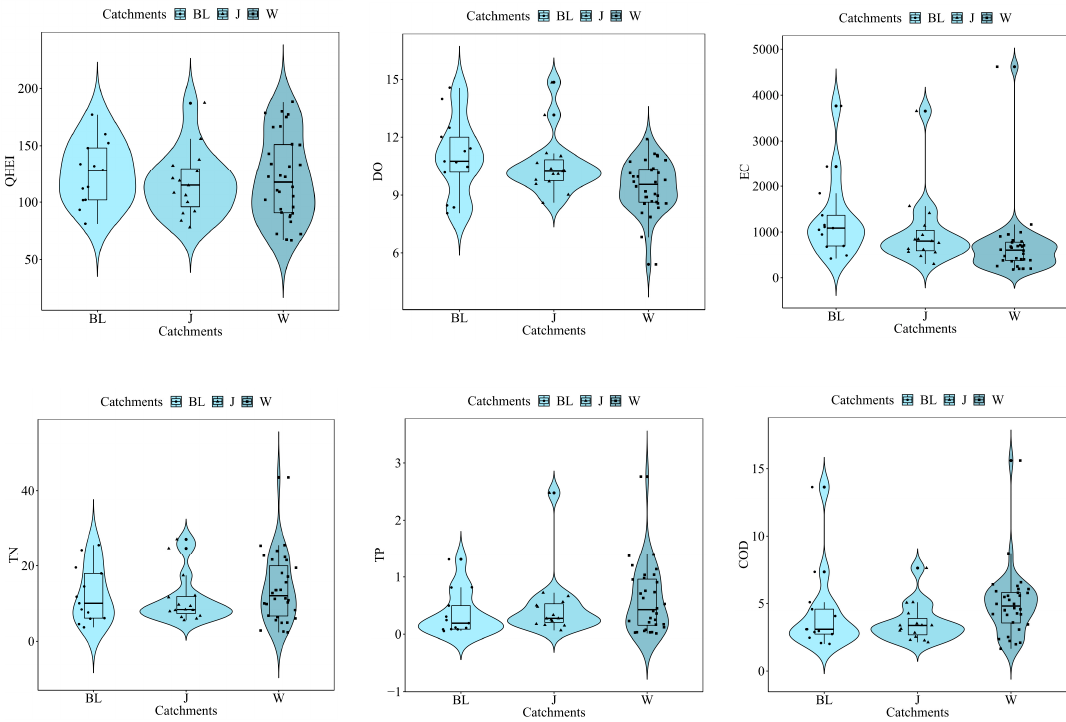
Figure 6. Distribution of physiochemical variables (QHEI, DO, EC, TN, TP, COD) at each catchment in the Wei River basin.